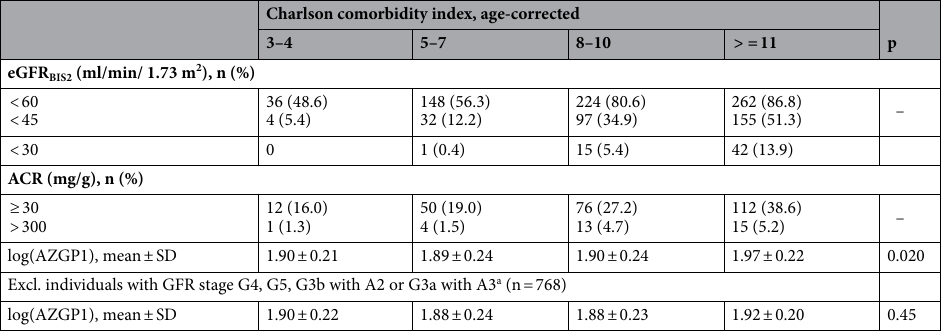
Table 2. Indicators of CKD and AZGP1 by CCI categories in the subsample and when excluding individuals without high risk of CKD according to KDIGO guidelines*. a Prognosis of CKD classified as “very high risk” according to KDIGO guidelines: eGFR < 30 ml/min/1.73 m 2 or eGFR < 45 ml/min/1.73 m 2 and